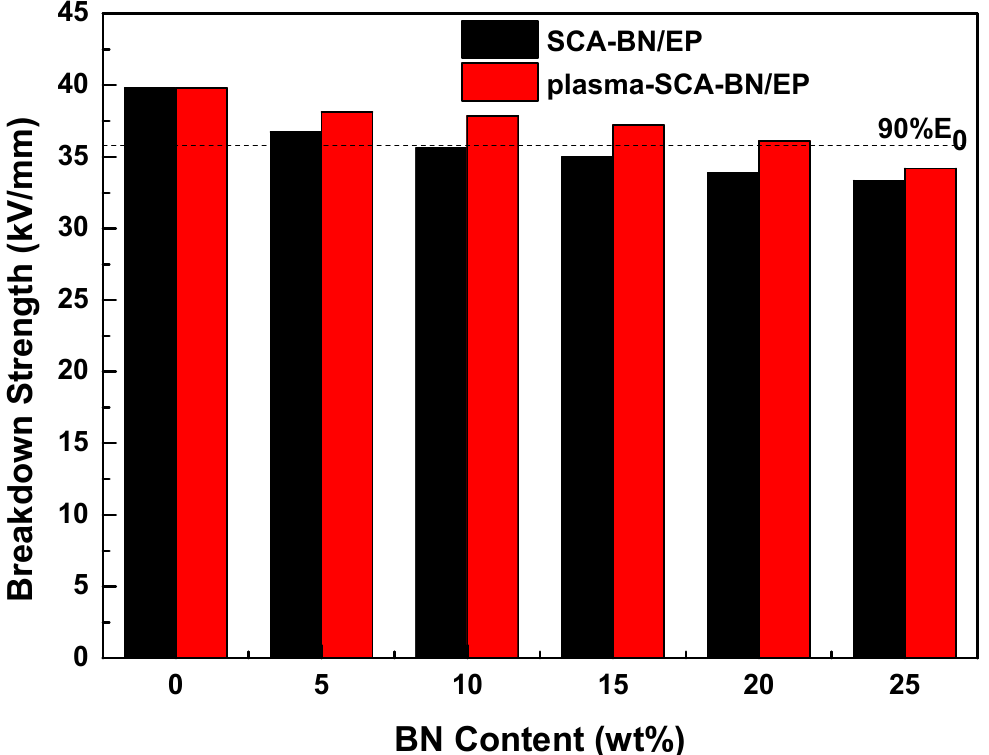
Figure 13. Breakdown strength of the EP and BN/EP nanocomposites with SCA treated BNNSs (SCA-BN / EP) and plasma and SCA treated BNNSs (plasma-SCA-BN / EP) at di ff erent contents.